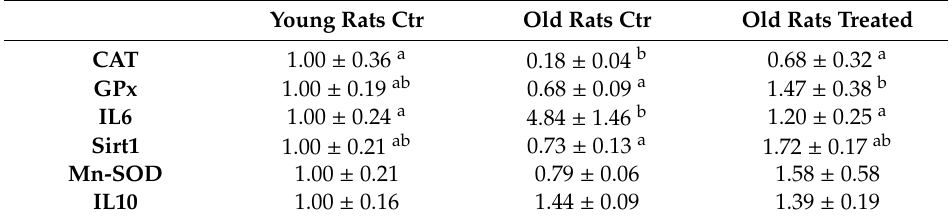
Table 2. E ff ect of Taurisolo ® chronic treatment on oxidative stress- and inflammation-related genes.